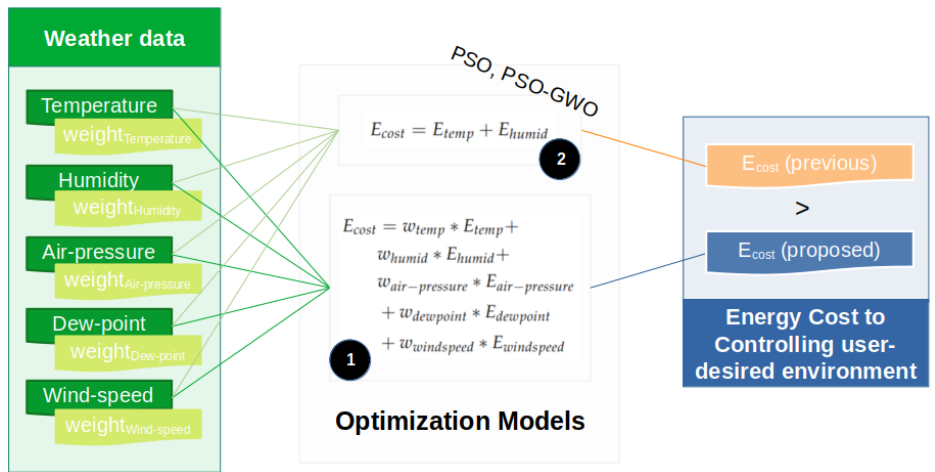
Figure 4. Proposed energy-optimization